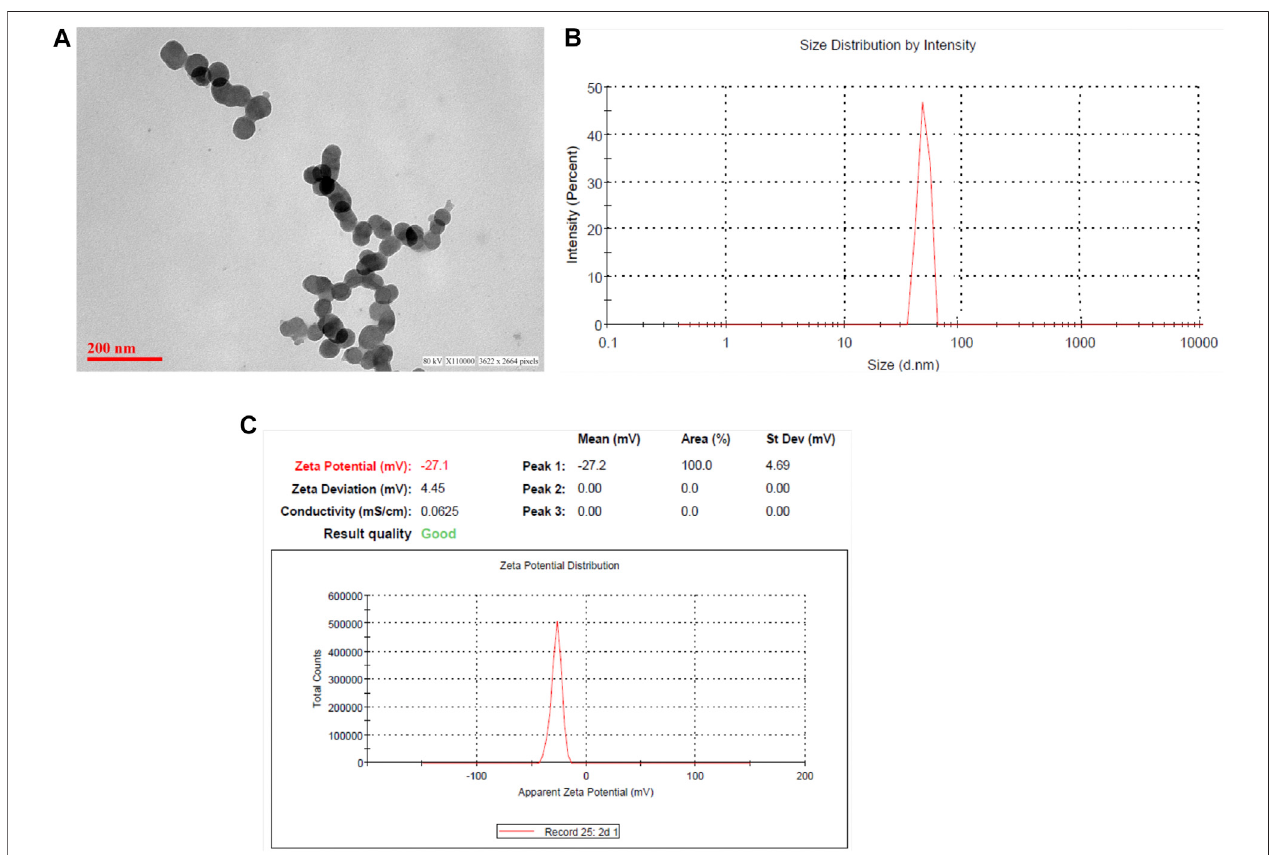
FIGURE 2 | Characterization of zinc oxide nanoparticles. (A) Transmission electron microscopy of zinc oxide nanoparticles; (B) the hydrodynamic size of NPs determined by dynamic light scattering (DLS) studies; and (C) zeta potential.